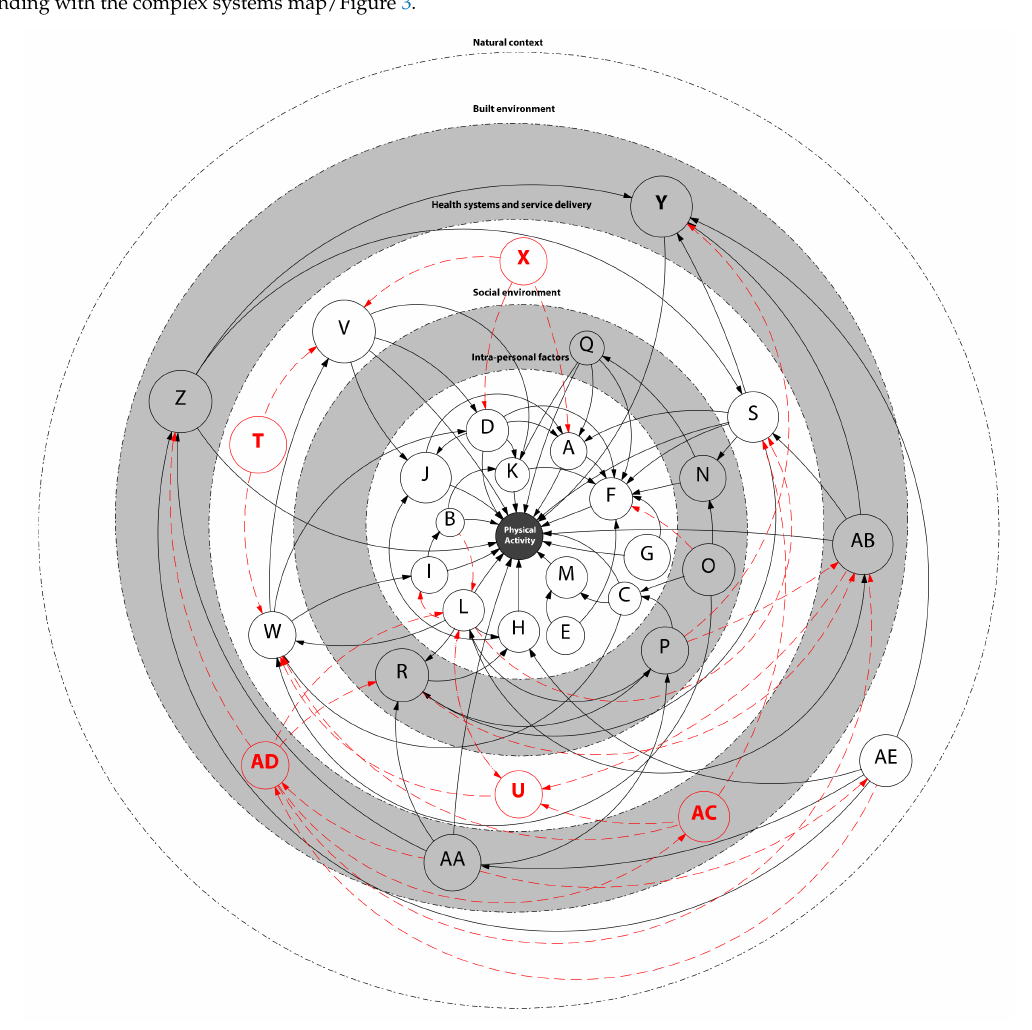
Figure 3. Systems map illustrating the complex nature of physical activity. The arrows indicate mechanisms through which various factors influence physical activity as informed by the underlying qualitative data (grey scale) or as identified within the multinational review team (red). Not all possible relations are shown, most relations will be bi-directional, and all factors are related to each other to some degree. The letters (e.g., A, B, AE, etc.) can be cross-referenced to the synthesised findings presented in Table 1. A high-resolution version of this figure, in which findings are presented in writing rather than coded, can be found in File